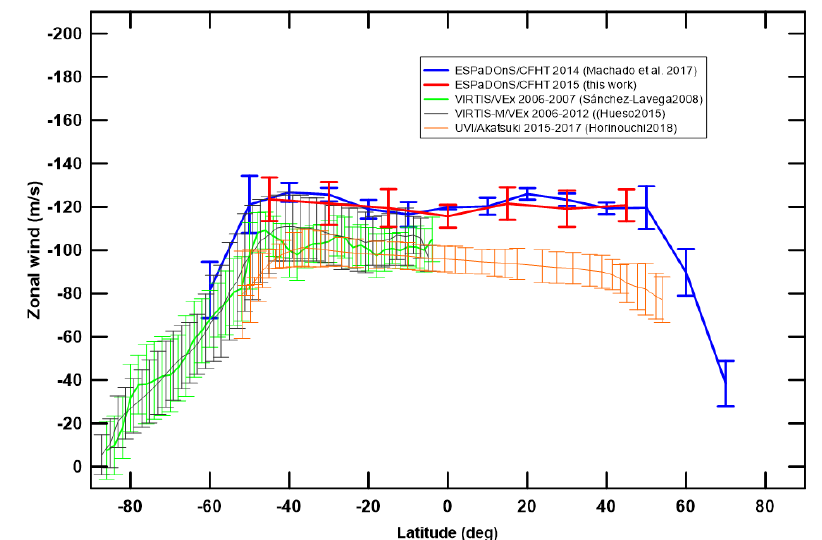
Figure 7. Long term comparison of zonal wind latitudinal profiles obtained from several observa- tions. The comparison includes results from Doppler velocimetry observations using ESpaDOn- S/CFHT from 2014 [10]), cloud-tracked observations using VIRTIS-M/VEx from 2006–2012 [7,9] and UVI/Akatsuki from 2015–2017 [11].